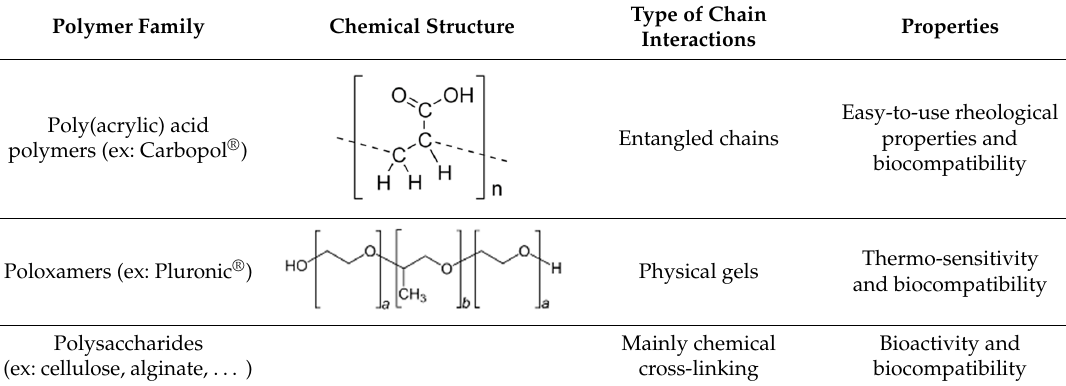
Figure 4. Percentage of occurrence of the different types of polymers used to form hydrogels entrapping LNP in the last twenty years. Table 1. Types of hydrogels used for LNP-hydrogel combination in the past 5 years.